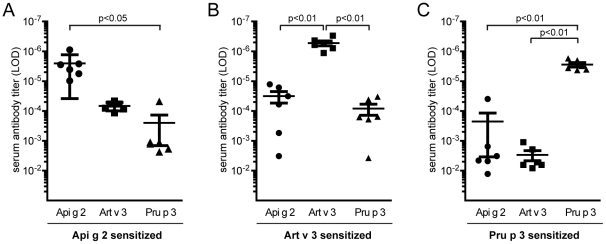
LTP cross-reactivity profiles of murine antibodies.Balb/c mice (n = 6) were immunized with purified Api g 2 (A), Art v 3 (B) and Pru p 3 (C). Allergen-specific IgG antibody titers to immobilized celery stalk, mugwort pollen and peach LTP were determined by limiting dilution in ELISA. Bars represent means and whiskers indicate standard errors of means. LOD, limit of detection.